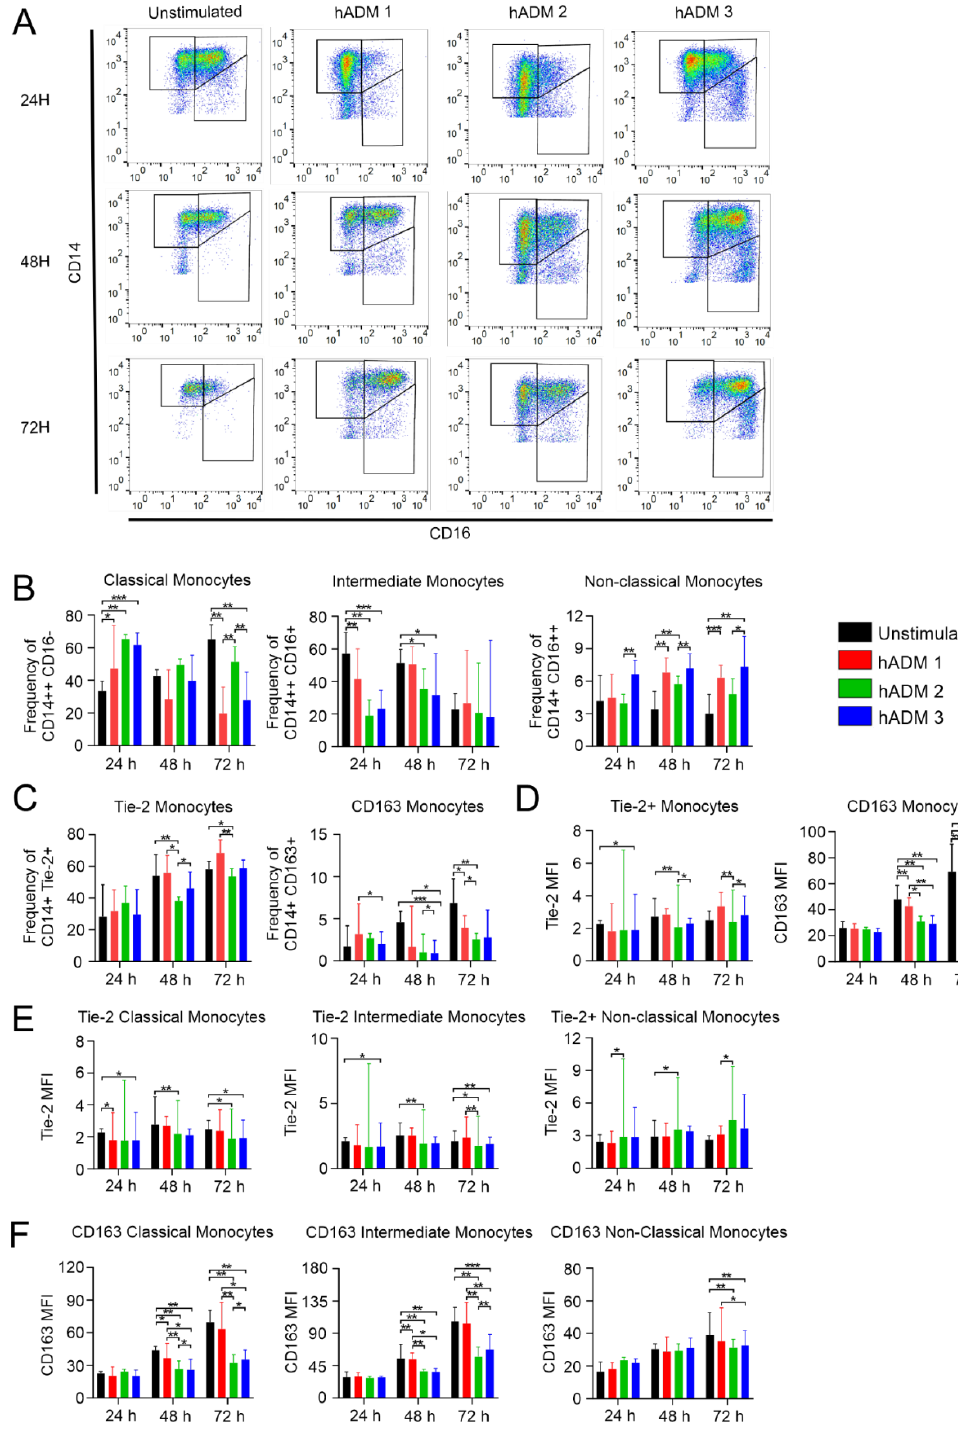
Figure 2. Monocyte phenotype is altered by hADM preparation method. Healthy donor PBMCs were co-incubated alone or with hADMs for 1, 2 or 3 days. Next, cells were stained extracellularly and examined by flow cytometry. ( A ) Representative CD14 × CD16 gating plots for each unstimulated and hADM condition at 24 h, 48 h and 72 h. ( B ) Subset frequencies for classical (CD14++/CD16 − ), intermediate (CD14++/CD16+), and non-classical (CD14+/CD16++) monocytes. ( C ) Frequency of CD14+/Tie-2 or CD163+ monocytes. ( D ) MFI quantification of CD14+ monocytes for Tie-2 or CD163. ( E ) Tie-2 MFI for specific monocyte subsets. ( F ) CD163 MFI for specific monocyte subsets. Results expressed as medians + interquartile ranges. Two-tailed Wilcoxon matched-pairs signed-rank test used for ( B – F ) n = 5 with 2 technical replicates; * p < 0.05, ** p < 0.01, *** p < 0.001.